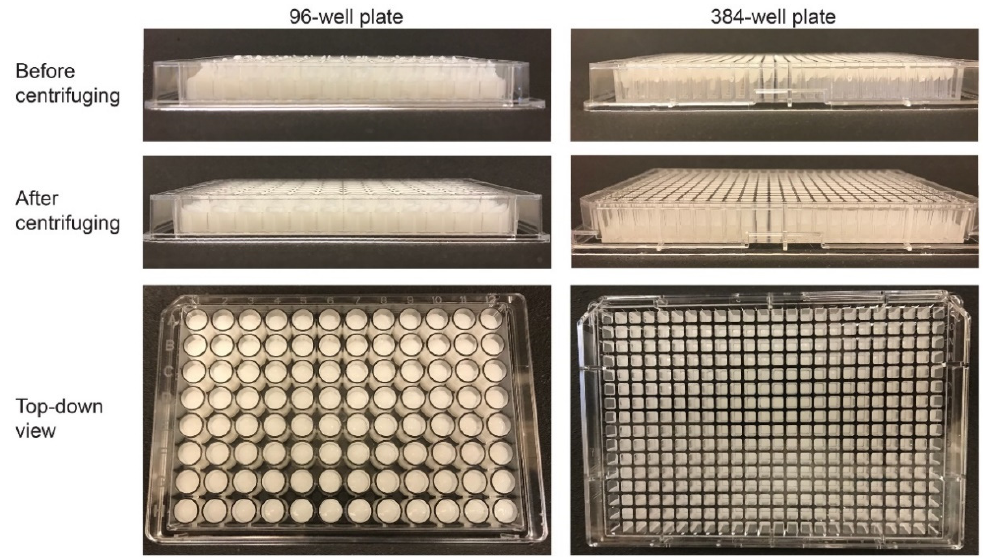
Figure 5. Dispensed scaffolds in 96 ‐ and 384 ‐ well plates. The images in the top row are side ‐ on views of the microplates before they were centrifuged. A close inspection shows that the heights of the scaffolds were uneven among wells. The second row depicts side ‐ on images of the scaffolds after centrifuging where the scaffolds heights were uniform among wells. The bottom row shows top ‐ down views of fully populated 96 ‐ and 384 ‐ well microplates. Table 1. Parameters used for automated casting of CA and CHA scaffold material.